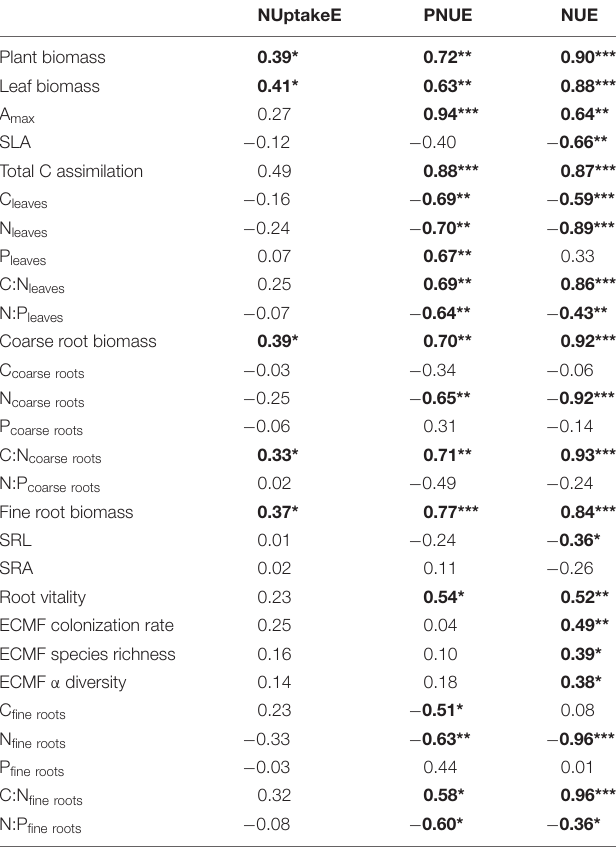
TABLE 3 | Pearson’s correlations between N uptake efficiency (NUptakeE), photosynthetic N use efficiency (PNUE), and N use efficiency (NUE) with plant biomass, leaf and root morphology, ectomycorrhizal fungal (ECMF) community, photosynthetic capacity, nutrient concentrations, and nutrient ratios of European beech saplings grown at increasing soil N:P ratios and climate